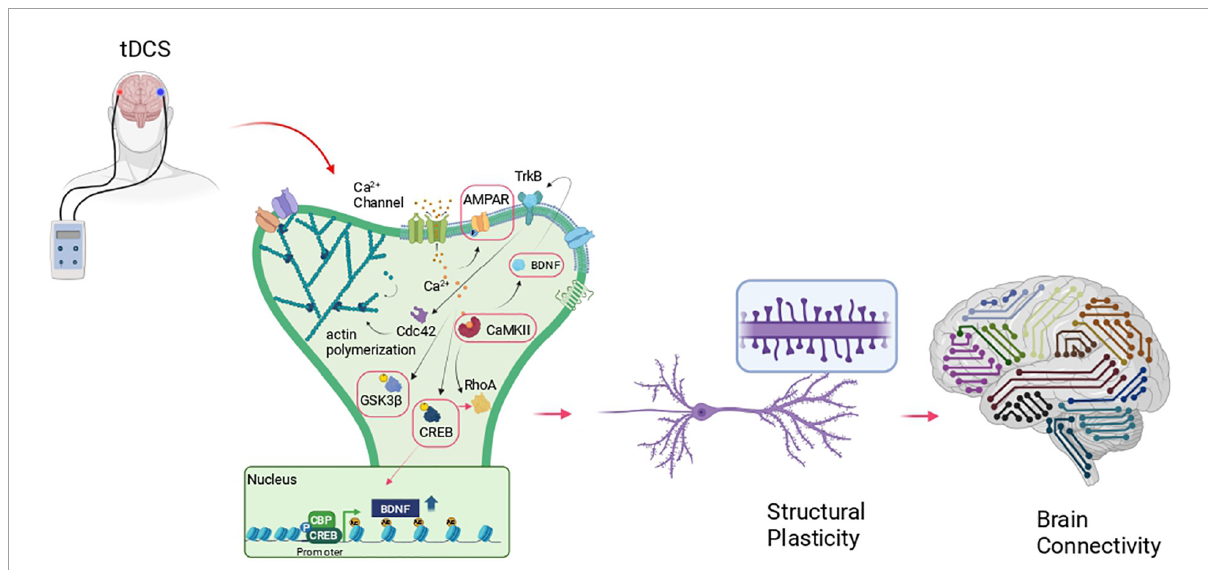
FIGURE1 Schematic representation of the molecular cascade at the basis of structural plasticity and its possible recruitment by tDCS. The red boxes indicate those molecules engaged by transcranial direct current stimulation (tDCS)- in different brain areas, in animal models that, so far, have been correlated to changes at synapses (i.e., enhanced LTP, synaptic transmission, dendritic spine density), increased learning and memory and enhanced connectivity. Created with